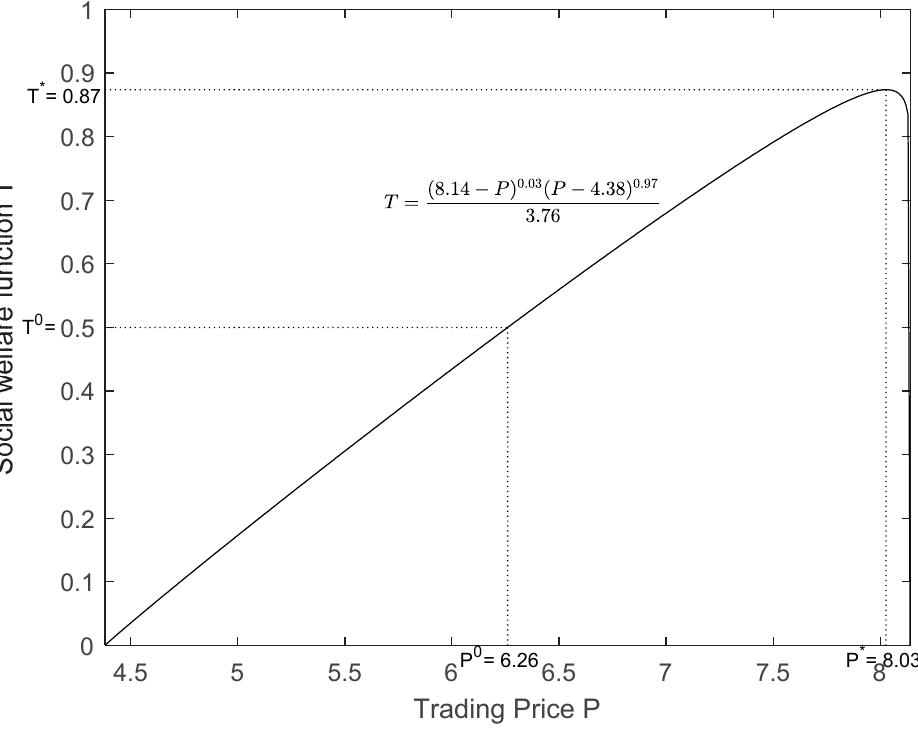
Figure 1. Schematic diagram of the optimal transaction price.